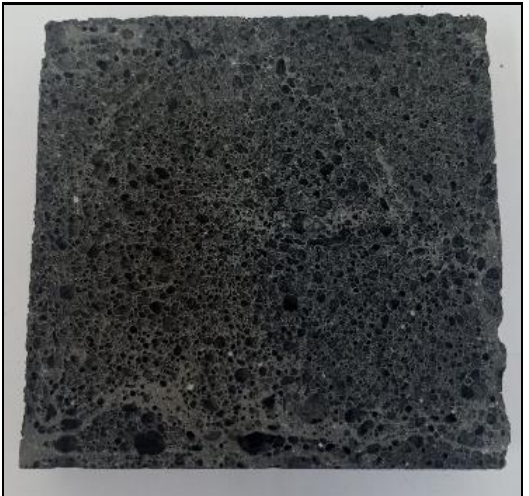
Figure 5. Reference sample with Al powder.